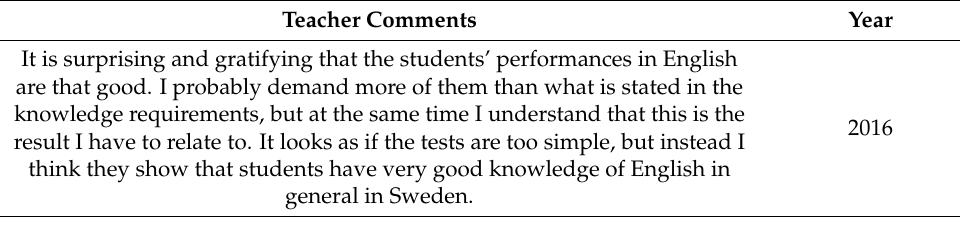
Table 10. Examples of teacher comments with a possible relation to final grading (2013, 2016 and